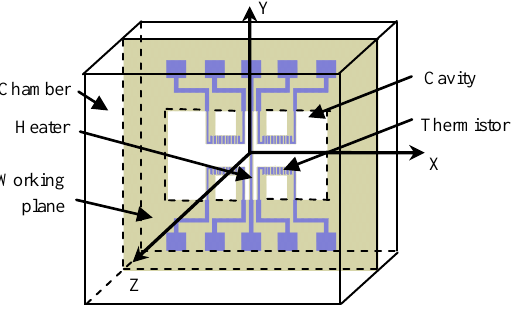
Figure 1. Conceptual design of a thermal gas gyroscope.